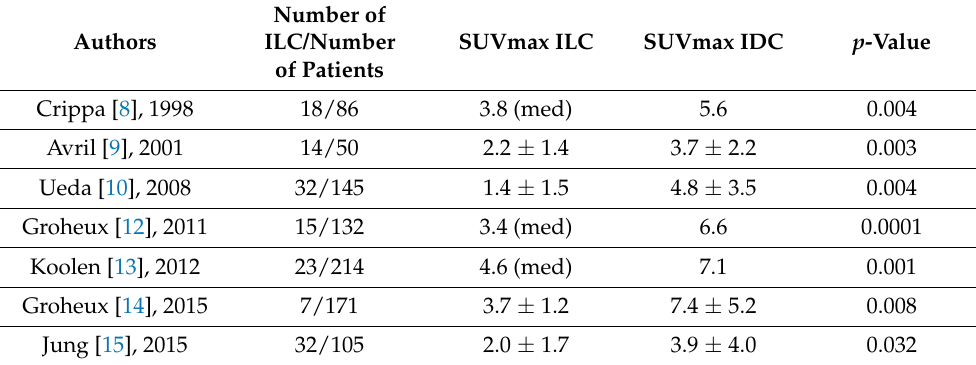
Table 3. Comparison of SUVmax in ILC and IDC available in the literature (med: